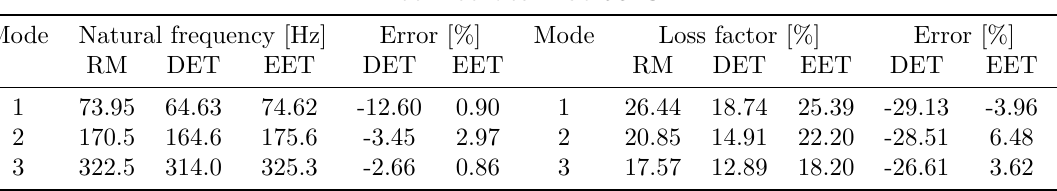
Table 4. Natural frequencies and loss factors for the three-layer laminated glass beam for the first three modes determined by the reference method (RM), the dynamic effective thickness method (DET), and the adjusted enhanced effective thickness approach (EET) with their errors against the reference method